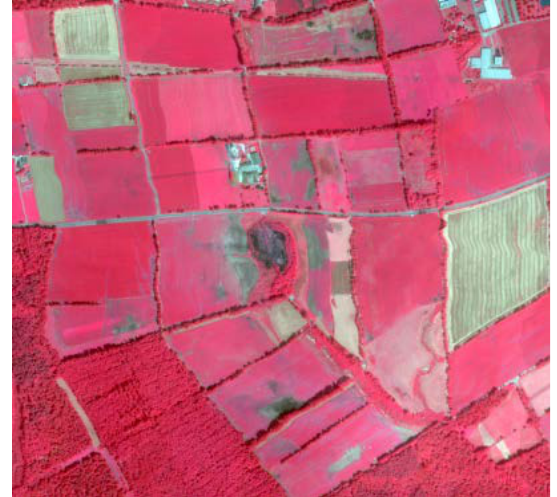
Figure 2. Central infrared bands of AISA Eagle acquired above our test site in western Germany. The scene comprises agriculture as well as forests and small settlements. Note the wavy roads, especially in the top left, which are a result of additional movement of the aircraft during image acquisition.